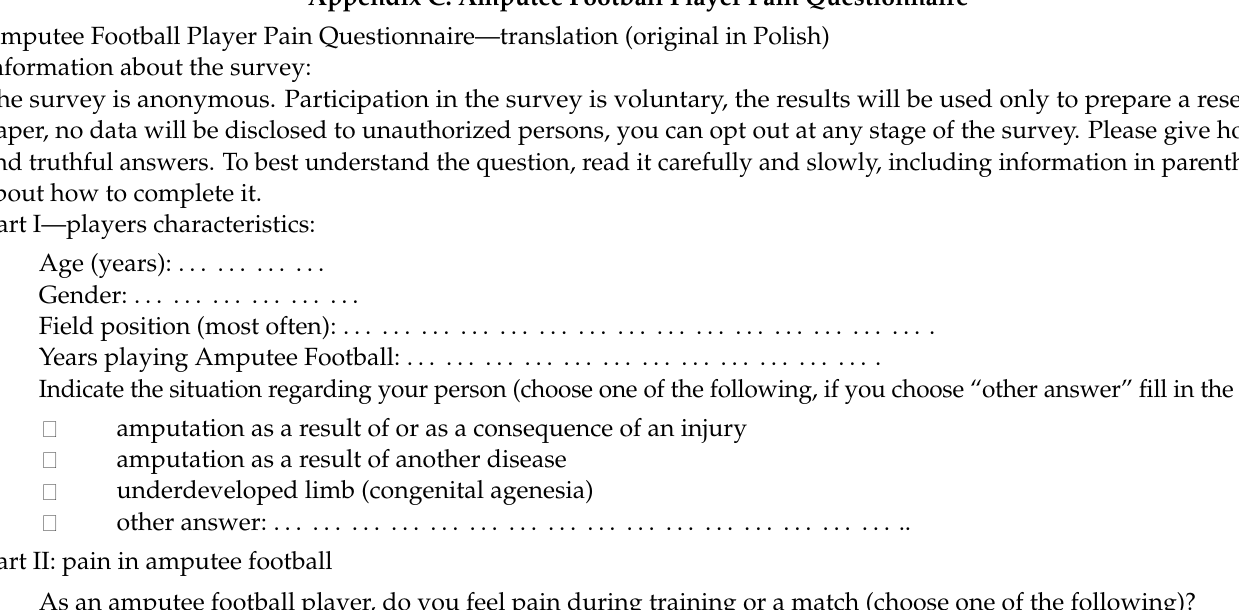
(Satellite Based Augmentation Stations) (European Geostationary Navigation Overlay Service) error correction.